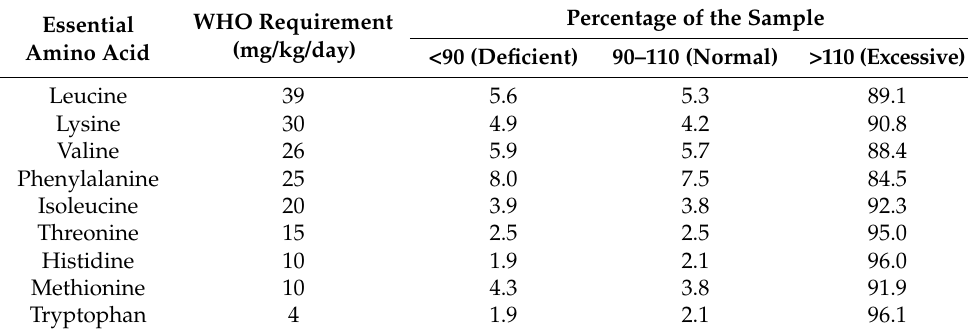
Table 2. Adequacy of intake for essential amino acids in ELANS.